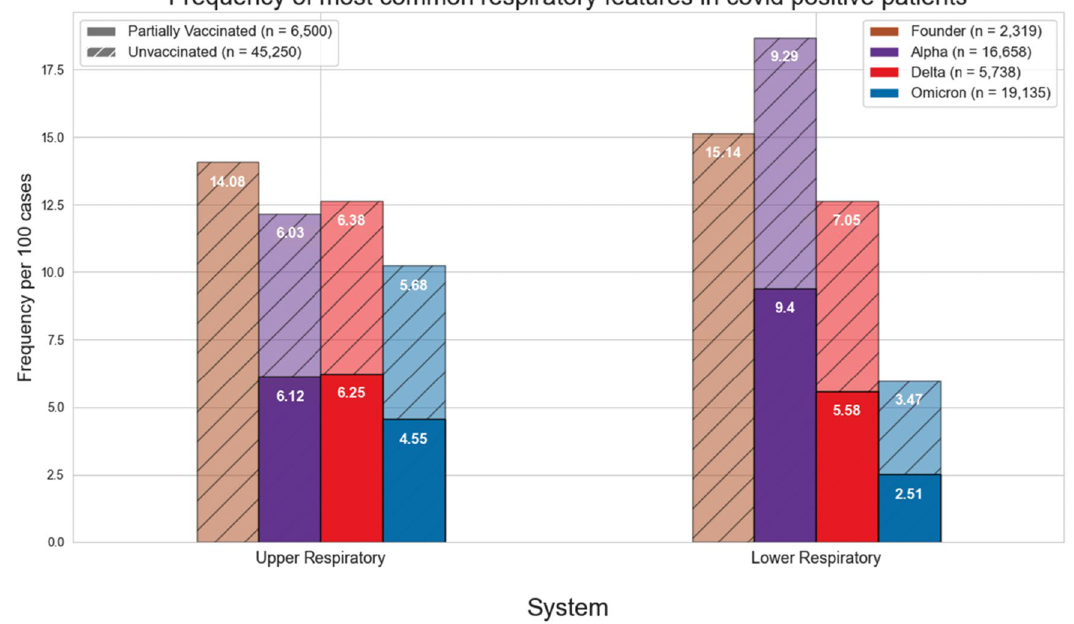
Figure 4. Comparison of frequency of most common respiratory features in COVID positive patients based on partially vaccinated or unvaccinated status.